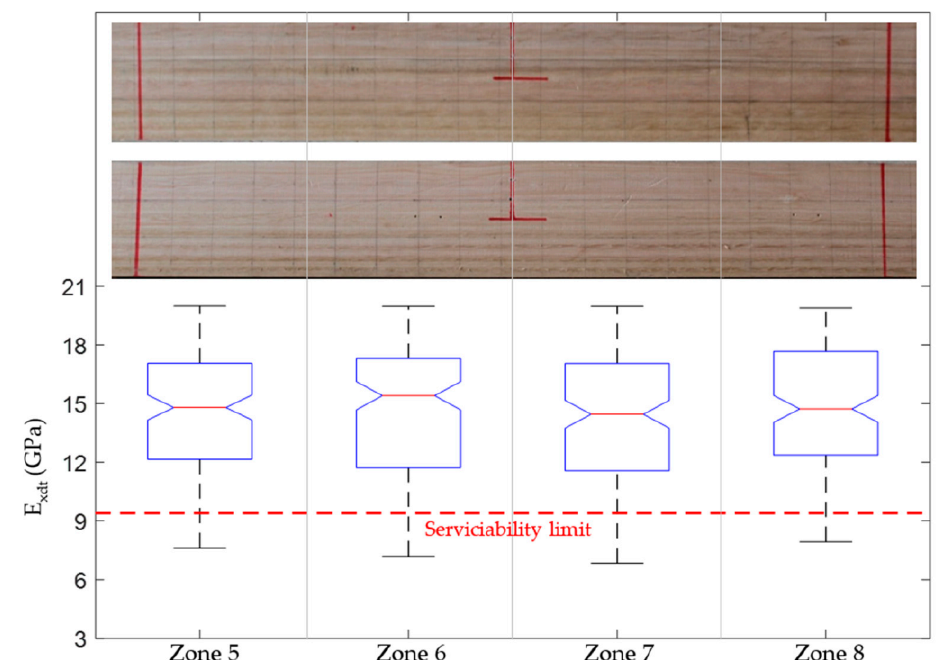
Figure 14. Boxplots of the four input factors located in the central third of the timber board # 33 ( E xdt in zones 5 to 8) for B sets. The pictures show the back and front of the lumber board in zones 5 to